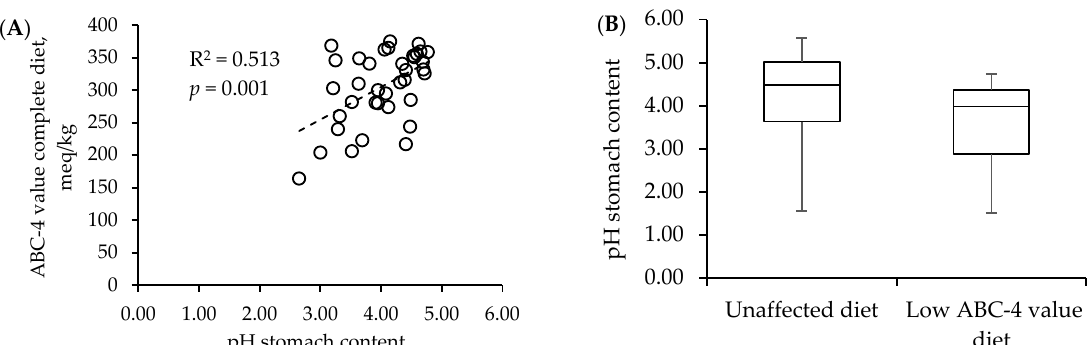
Figure 3. Relationship between the acid-binding capacity (ABC)-4 value of the complete diet and stomach pH. ( A ) shows the correlation between the ABC-4 value of the complete diet and stomach pH. The data represent the ABC-4 value of 31 experimental diets containing protein-rich feedstuffs (6–8 piglets/experimental treatment) (between 2017 and 2019; Schothorst Feed Research B.V., Lelystad, The Netherlands). The ABC-4 value was measured in meq/kg using the methodology described by Lawlor et al. [151]. Each dot represents the average stomach pH per dietary treatment. ( B ) shows the effect of acidifying the complete diet on individual stomach pH. The experimental diets contained one of three different protein-rich feedstuffs that are known for their high (i.e., fish meal), intermediate (i.e., Hi-Pro Soybean Meal) and low ABC-4 value (i.e., maize gluten). The values displayed in ( B ) represent the stomach pH from all protein-rich feedstuffs together. The low ABC-4 diets were acidified by replacing limestone with calcium formate (either completely or partially) and adding citric acid. The unaffected diets did not contain organic acids. The average ABC-4 values of the unaffected diet were 308 meq/kg (SD = 26), with a value of 243 meq/kg (SD = 95) for the low ABC-4 diets. The average stomach pH of the unaffected diet was 4.22 (SD = 0.997), with a value of 3.57 (SD = 1.075) for the low ABC-4